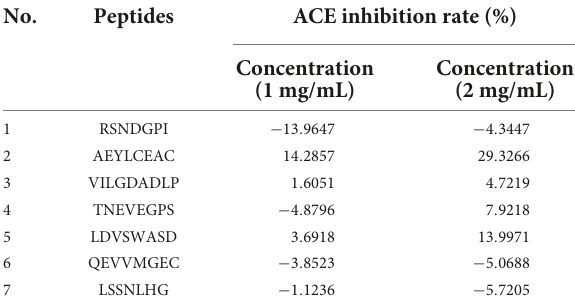
TABLE 2 The ACE inhibition rates of seven potential ACEI peptides at different concentrations (1 and 2 mg/mL). No. Peptides ACE inhibition rate